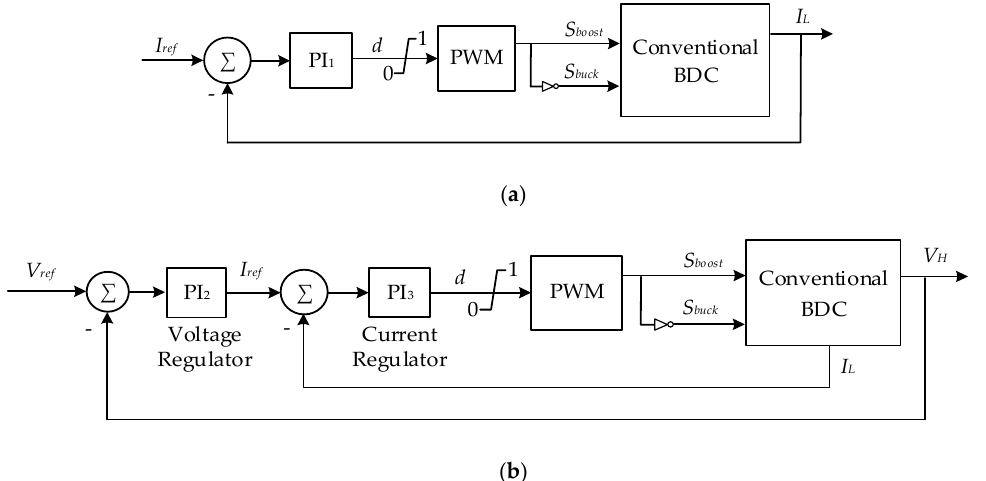
Figure 17. Conventional BDC control systems used for comparison analysis. ( a ) Current control; ( b ) voltage control. Table 3. Conventional BDC parameters.